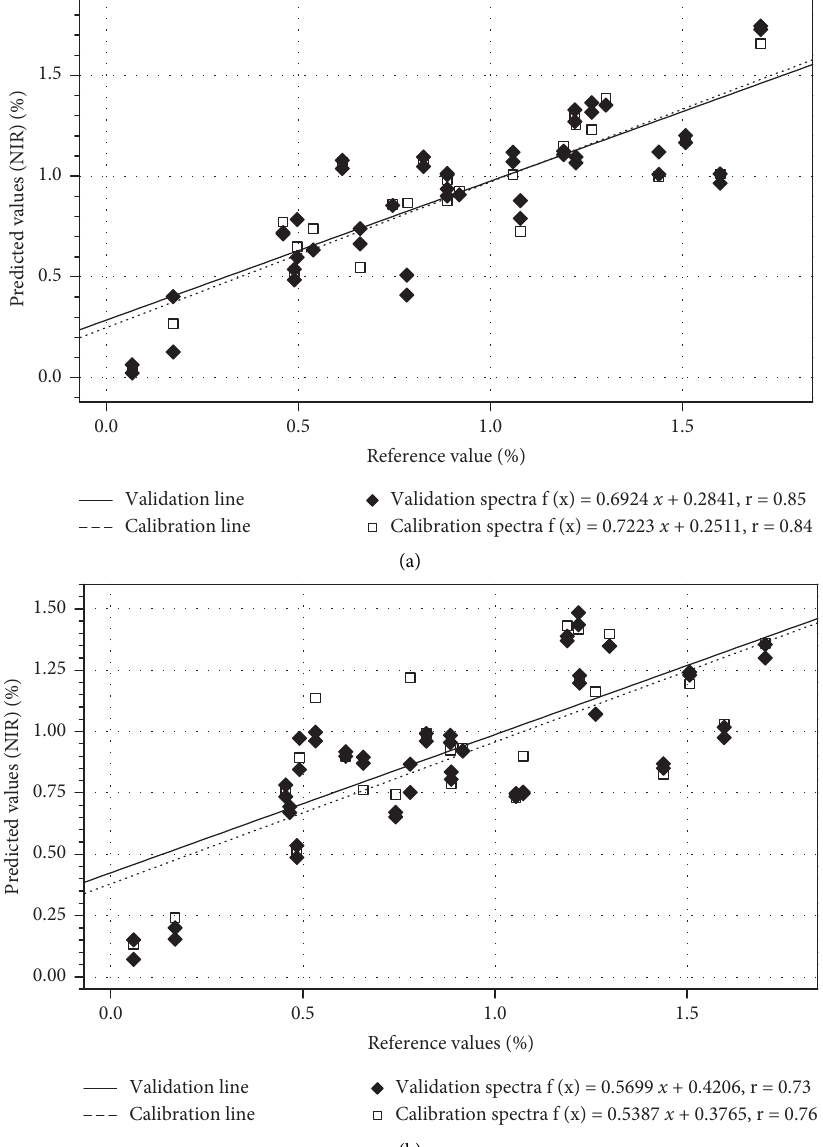
Figure 2: PLS regression lines of the SCM (a) and the MCM (b) model for determining the n-decanoic acid content in A. millefolium